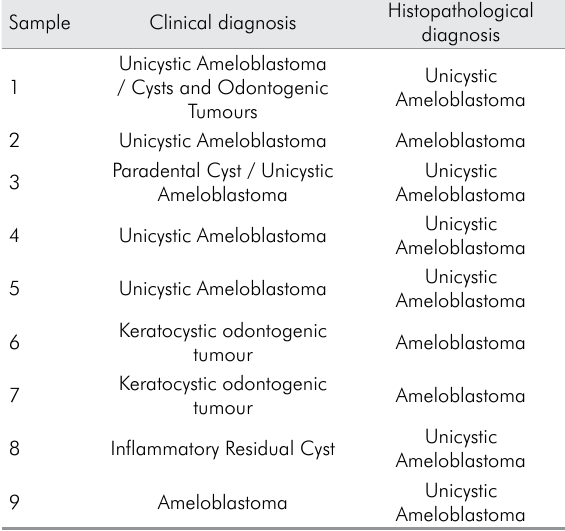
Table 1. Clinical diagnosis versus histopathological diagnosis